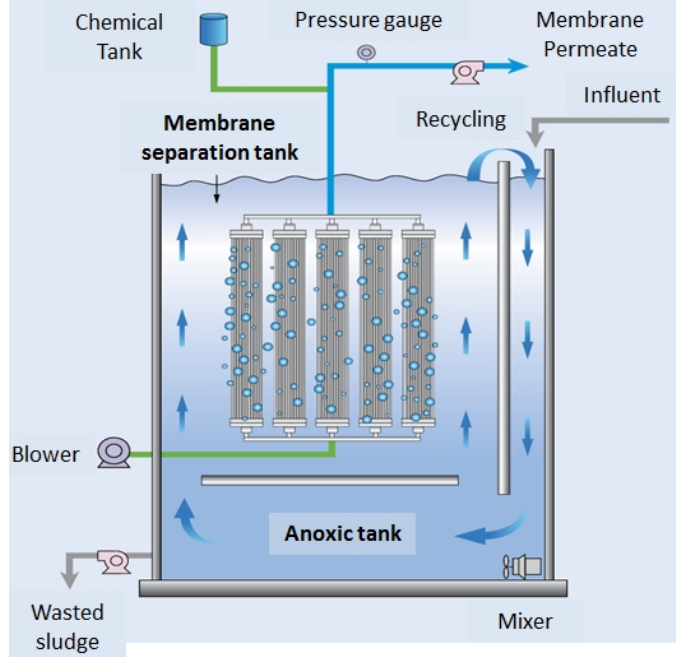
Figure 1. Schematic diagram of a field-scale DMBR TM